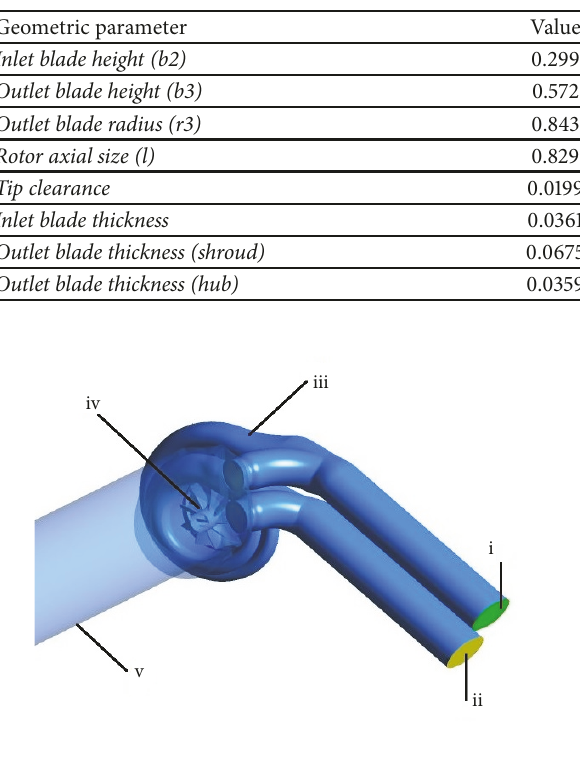
Figure 2: Turbine CFD domain: (i)-(ii) inlet sections, (iii) volute domain, (iv) rotor domain, and (v) out domain.